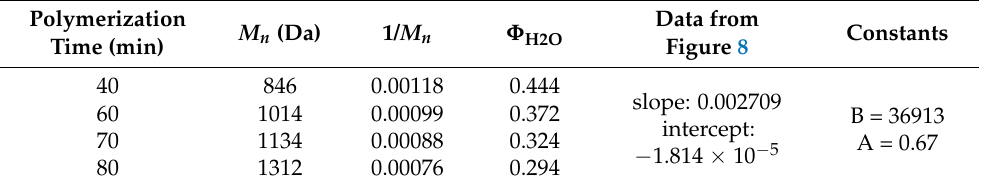
Table 2. The molecular mass and volume fraction data for the calculation of A and B constants for